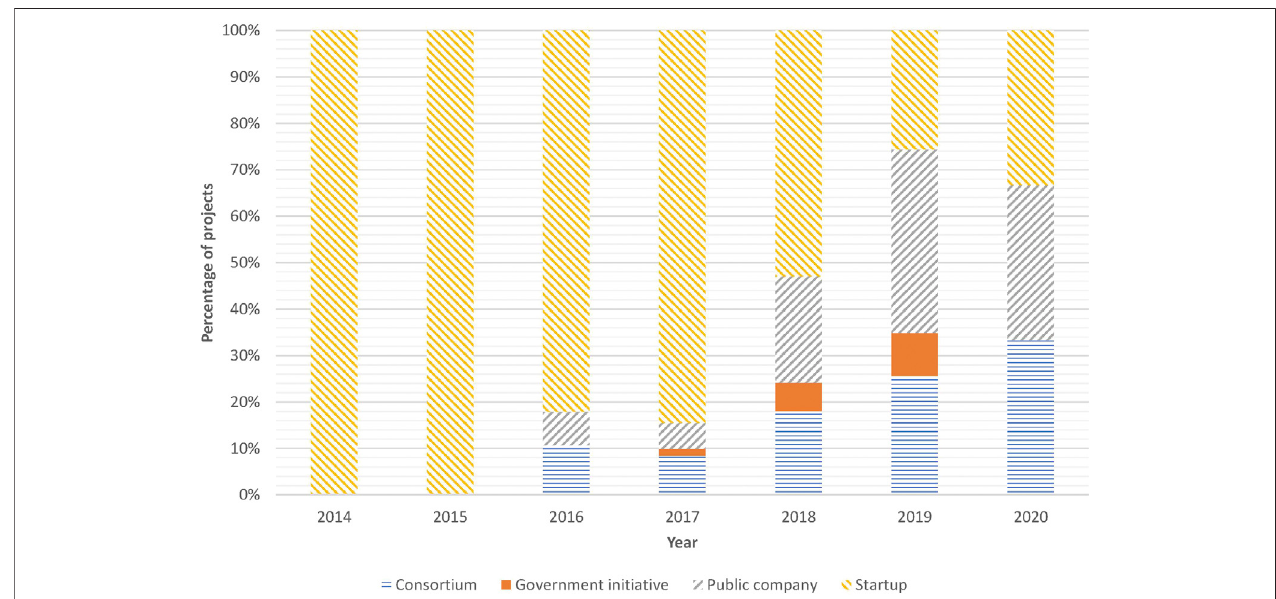
FIGURE 4 | The percentage of different types of organization leading projects based on the project ’ s year of creation.